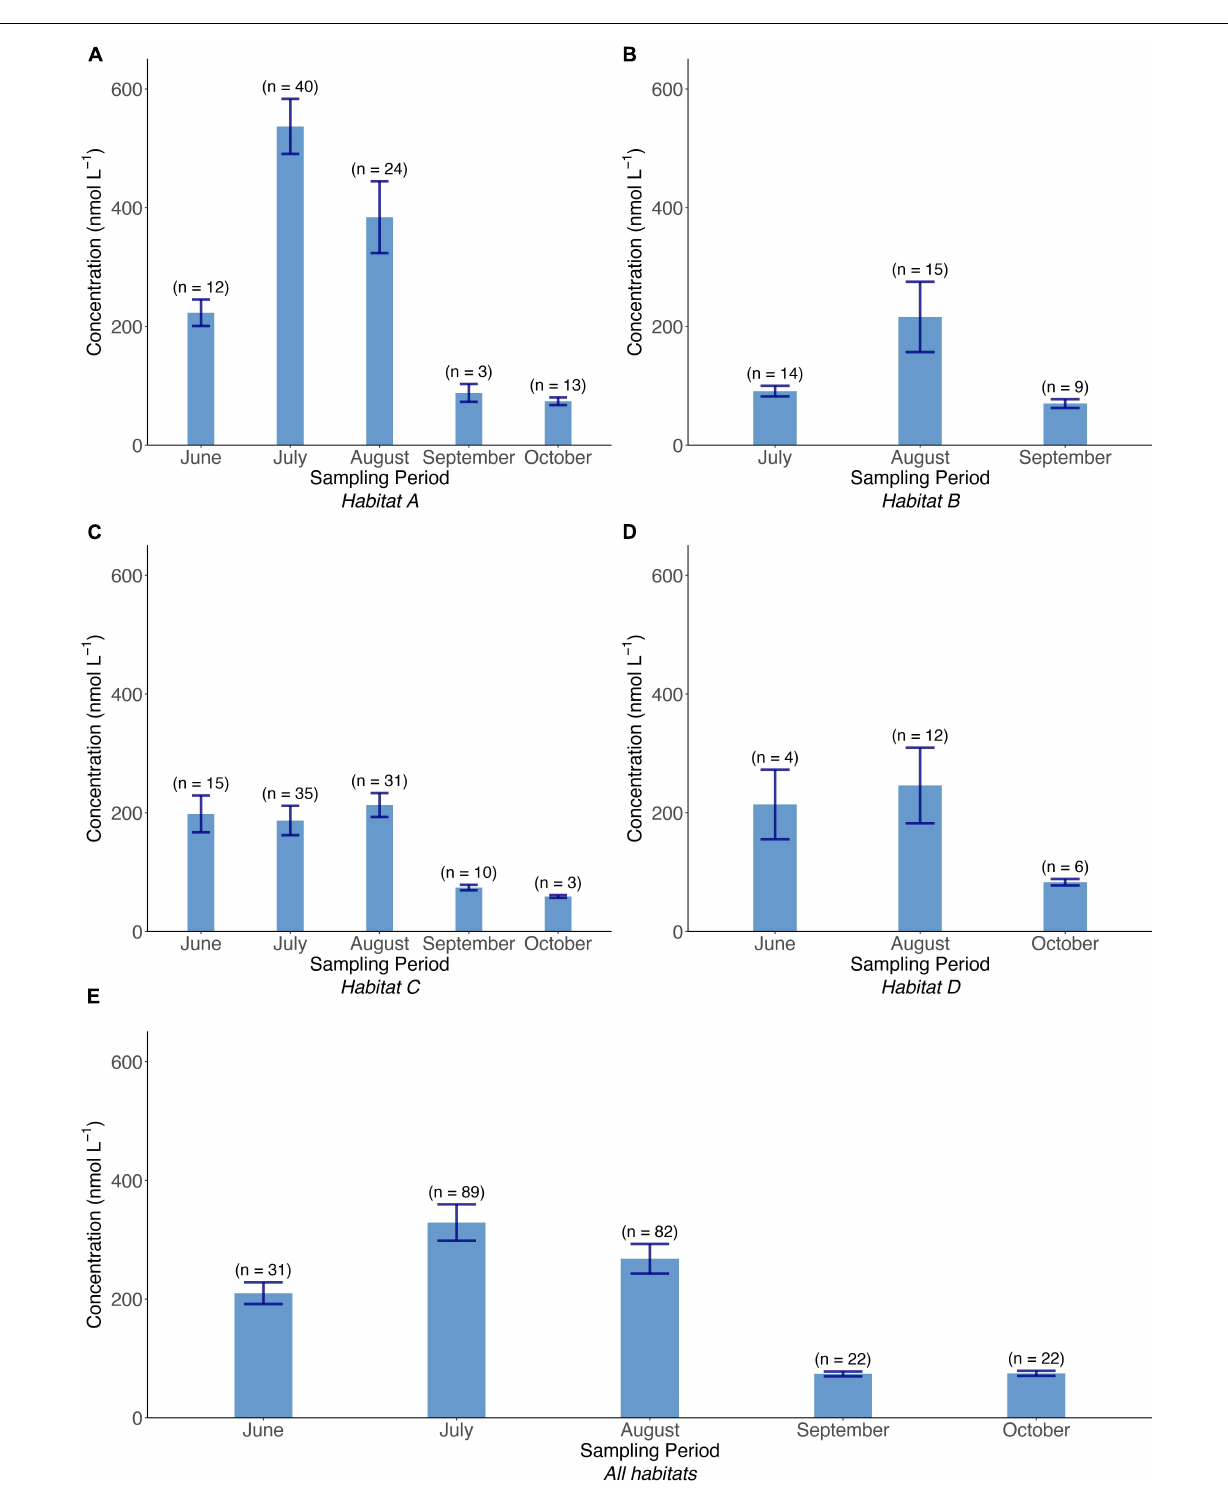
Frontiers in Marine Science |